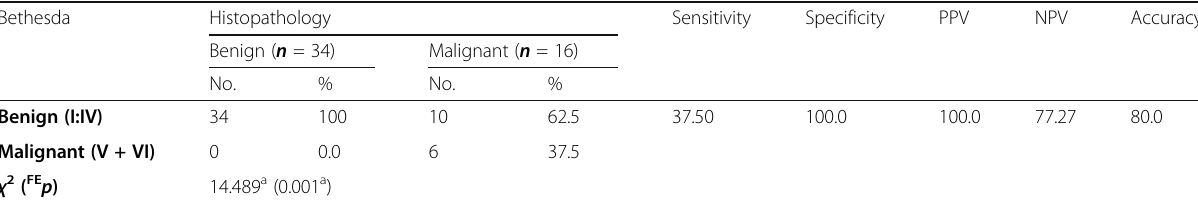
Table 6 Sensitivity and specificity for FNAB